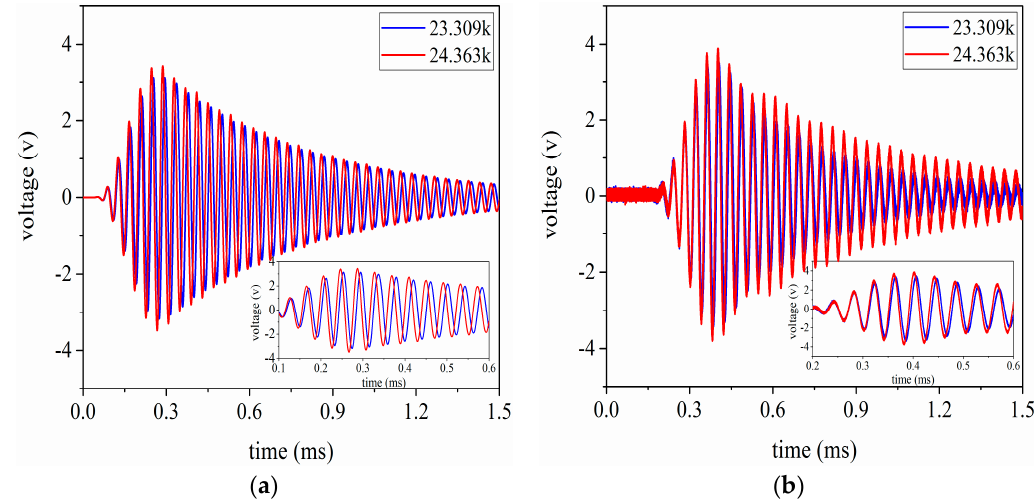
Figure 18. The signal waveform received by the ultrasonic transducer under the condition that the aluminum cylinder is 100 mm in length, ( a ) the simulated results; ( b ) experimental results.